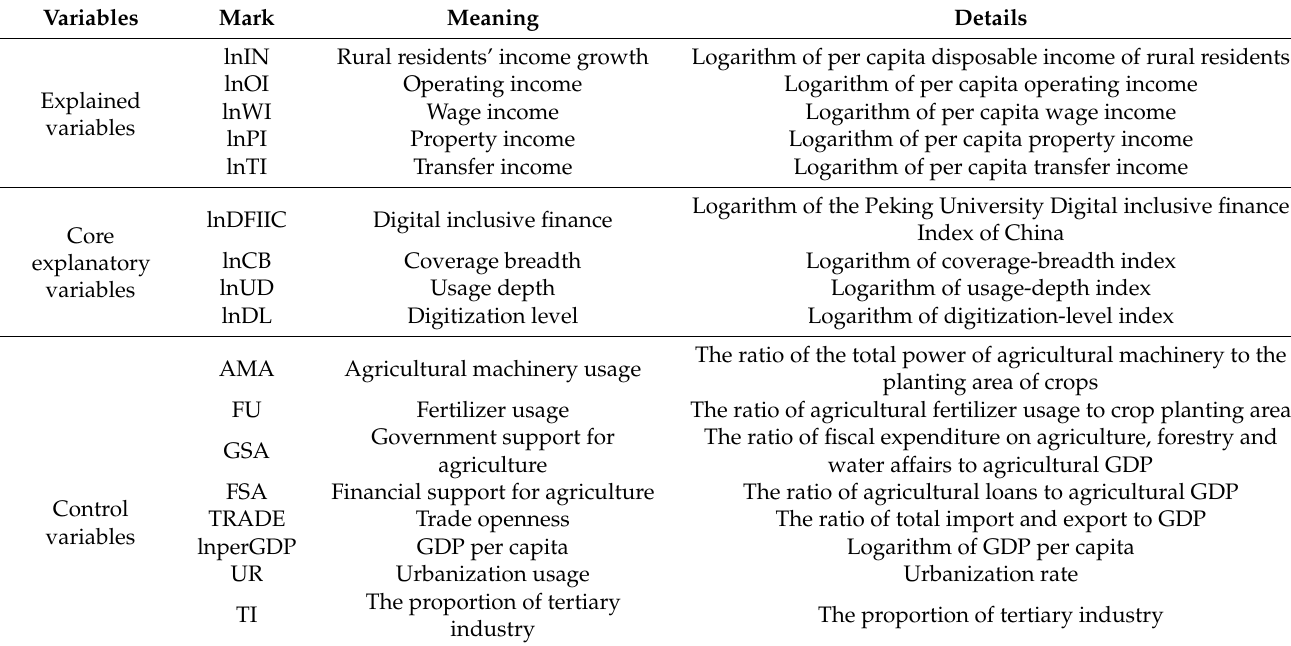
Table 1. Variable definitions.